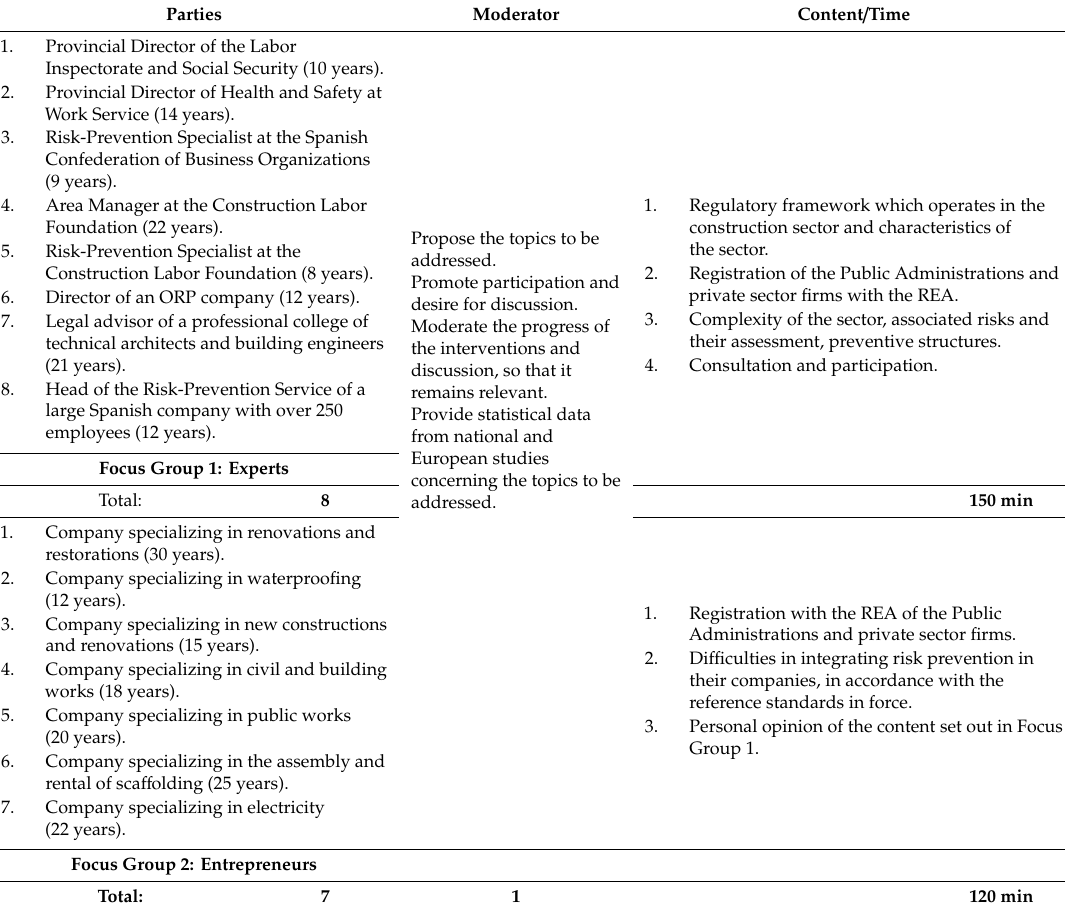
Table 3. Position of the intervening parties / experience in years, duties of the moderator, debate content and duration. Source: Mind the Gap: Professionalization is the Key to Strengthening Safety and Leadership in the Construction Sector